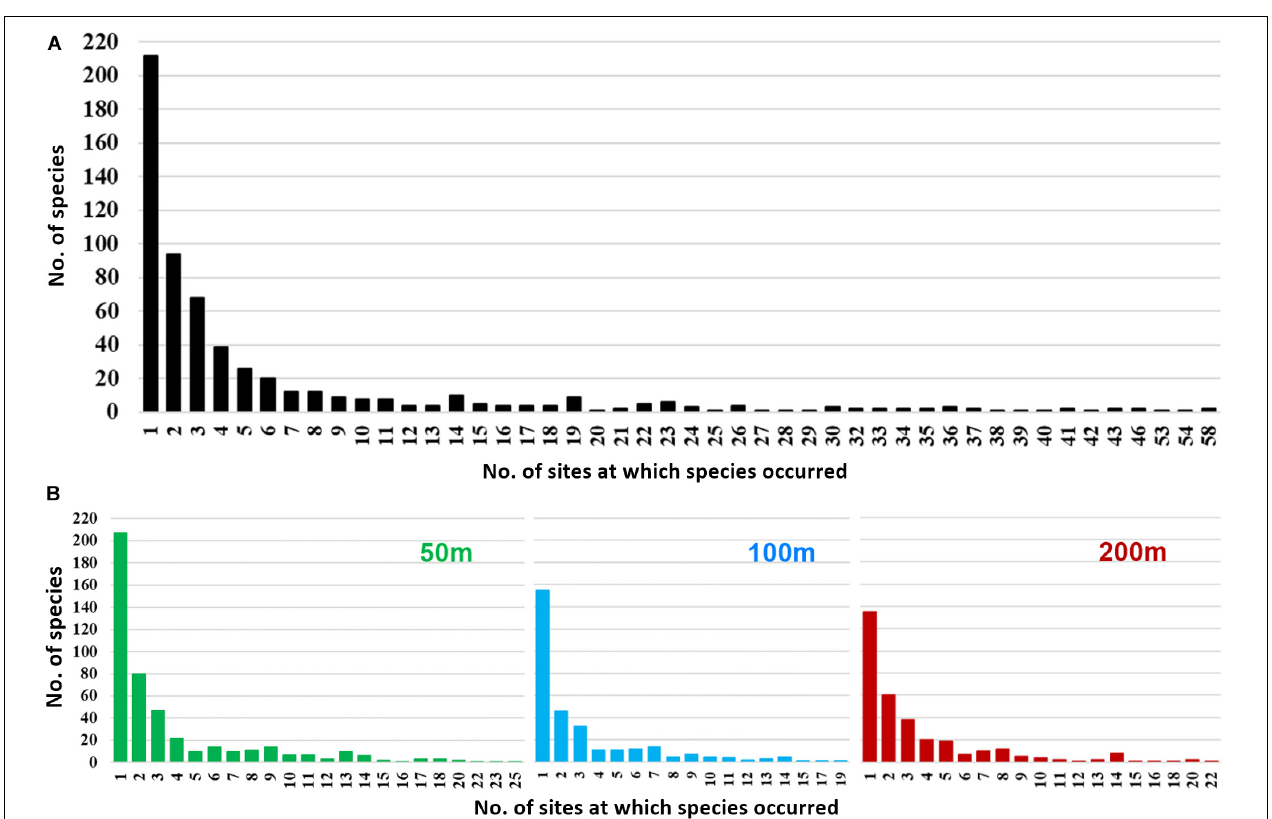
FIGURE 7 | Proportion of rare polychaete species based on number of species ( y axis) occurring at exactly n sites ( x axis), (A) in the entire study area (black bars), and (B) at 50 m (green bars), 100 m (blue bars), and 200 m (red bars) depth